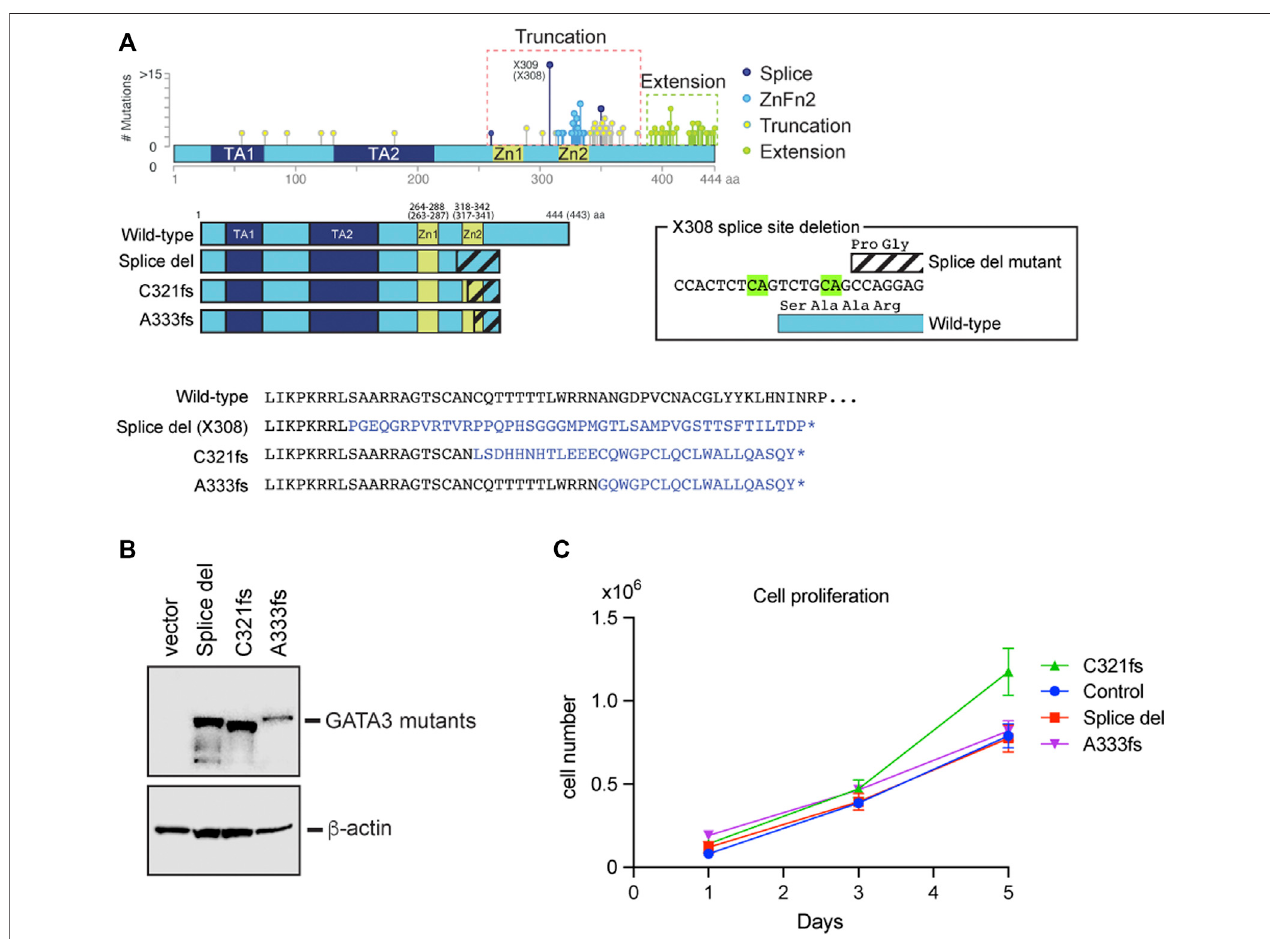
FIGURE 1 | Establishment of GATA3 truncation mutant cell lines. (A) Distribution of GATA3 mutations found in METABRIC cohort. Based on the protein products and mutation sites, four groups were generated (Takaku et al., 2018). The secondary structure of GATA3 mutants used in this study is indicated. The altered amino acid residuesareshownonthebottom.TheX308splicesitedeletionanditseffectontheGATA3proteinareindicatedinbox. (B) WesternblotshowingGATA3mutants.Anti- Ty1 antibody was used to detect each mutant. β -actin levels were used as input control. (C) Cell growth comparison between GATA3 mutant expressed T47D cells. The average cell number is indicated at each time point with each of their standard deviations (N = 3).